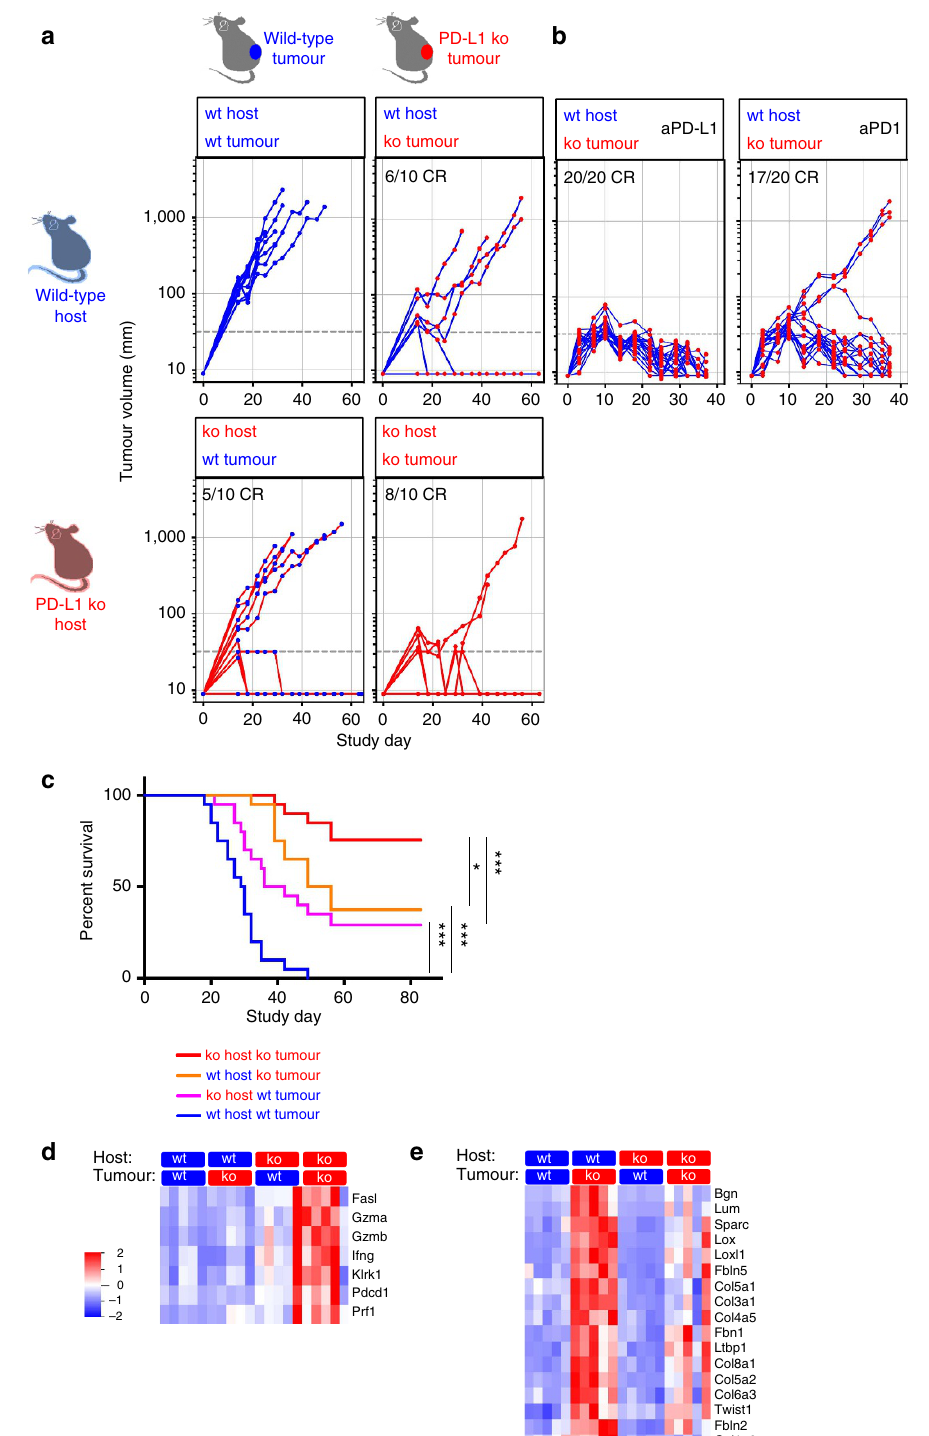
Figure 5 | Deletion of PD-L1 from both tumor and host compartments lead to most profound frequency of tumor regressions. Tumour growth and frequency of regressions of wild-type (blue marker) and PD-L1-deficient (red marker) MC38 tumours in wild-type (blue line) and PD-L1-deficient (red line) host mice ( a ), with highest frequency of regressions observed when PD-L1 was genetically ablated in the tumour and the host compartment. Statistical significance was analysed in two repeat studies ( c : summary of two independent repeat studies with n ¼ 10 per group per study; Mantel-Cox log-rank test; detailed statistics shown in table 1). Concomitant treatment of PD-L1-deficient tumours with either anti-PD-L1 or anti-PD-1 blocking antibodies increased frequency of tumour regressions ( b ). Optimal T-cell activation as represented by cytolytic gene expression required deletion of PD-L1 in both tumour and host compartment ( d ), and alleviated degree of potential resistance mechansims represented by stromal remodelling and EMTgene expression ( e ). In tumour growth curves, PD-L1 status of the host is the line colour whereas the tumor status is the symbol colour. Gene expression analysis limited to genes meeting Q value o 0.05. Error bars depict s.d. from the mean. Mouse cartoon modified from ref. 15.